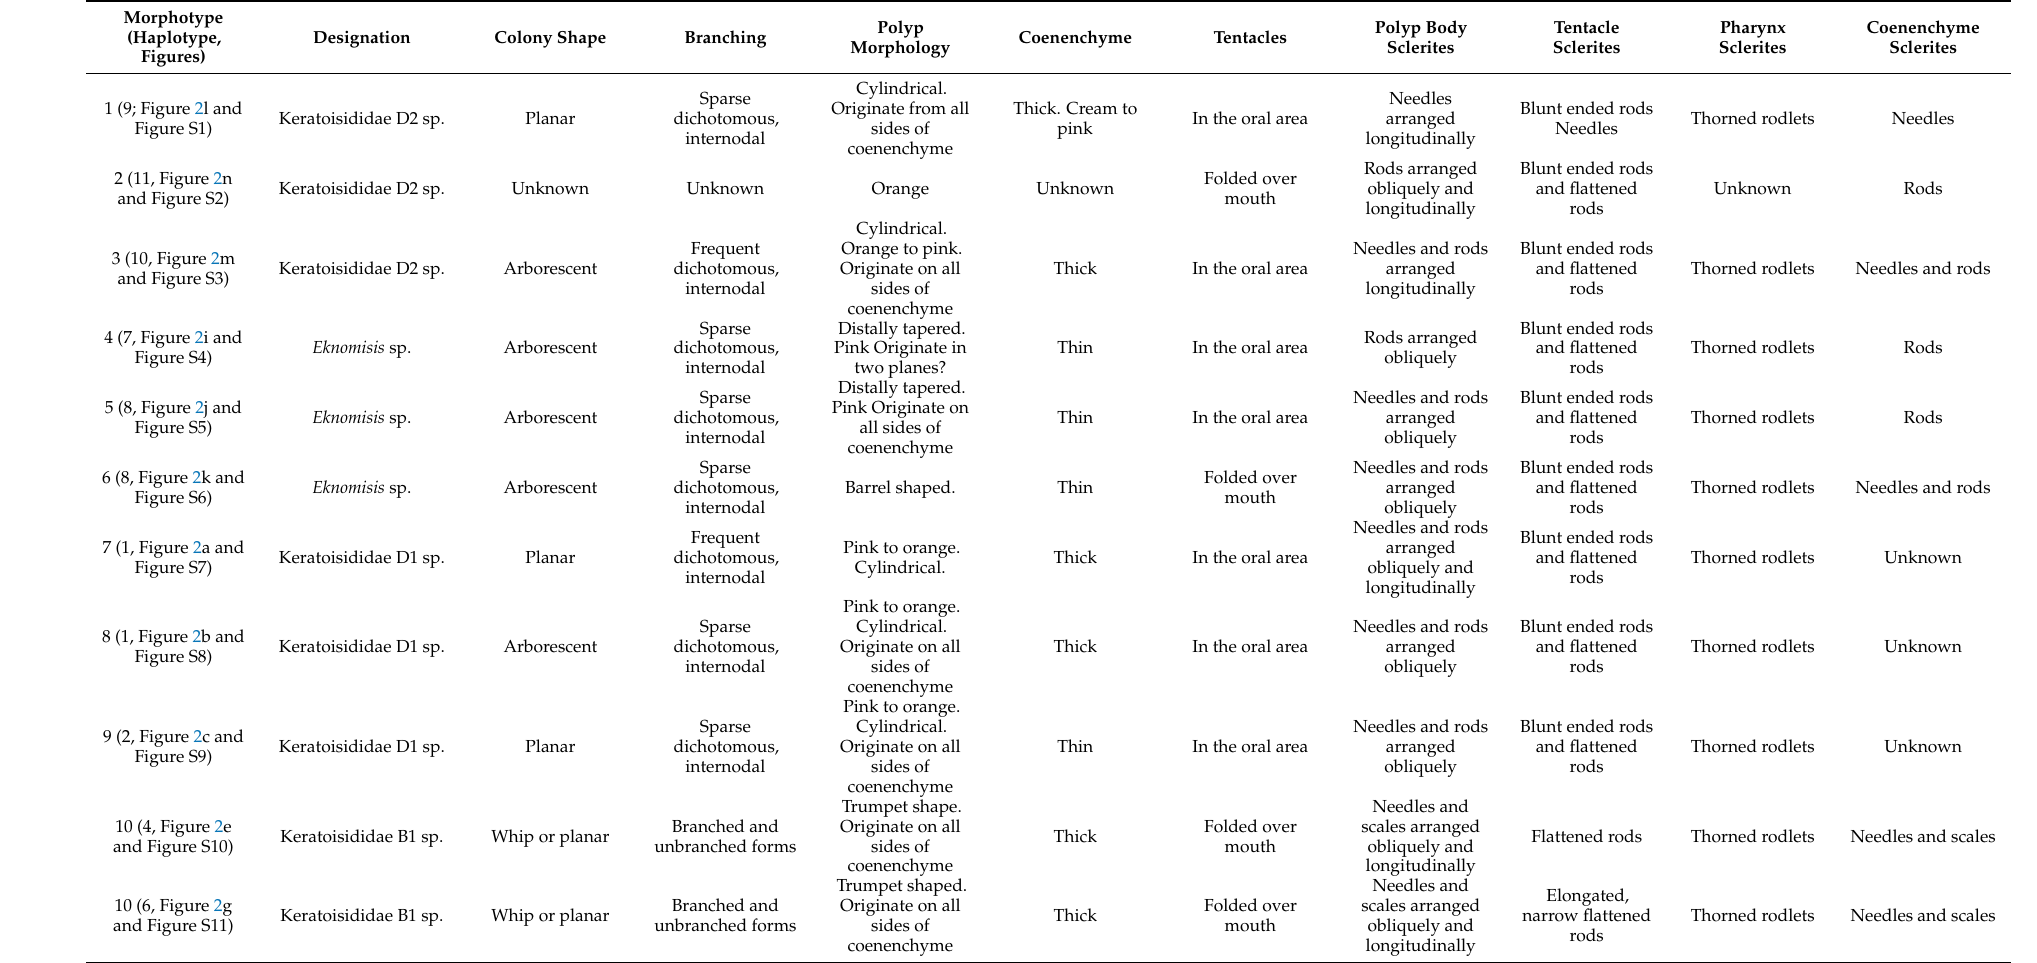
Table 3. Key morphological characteristics of the Keratoisididae